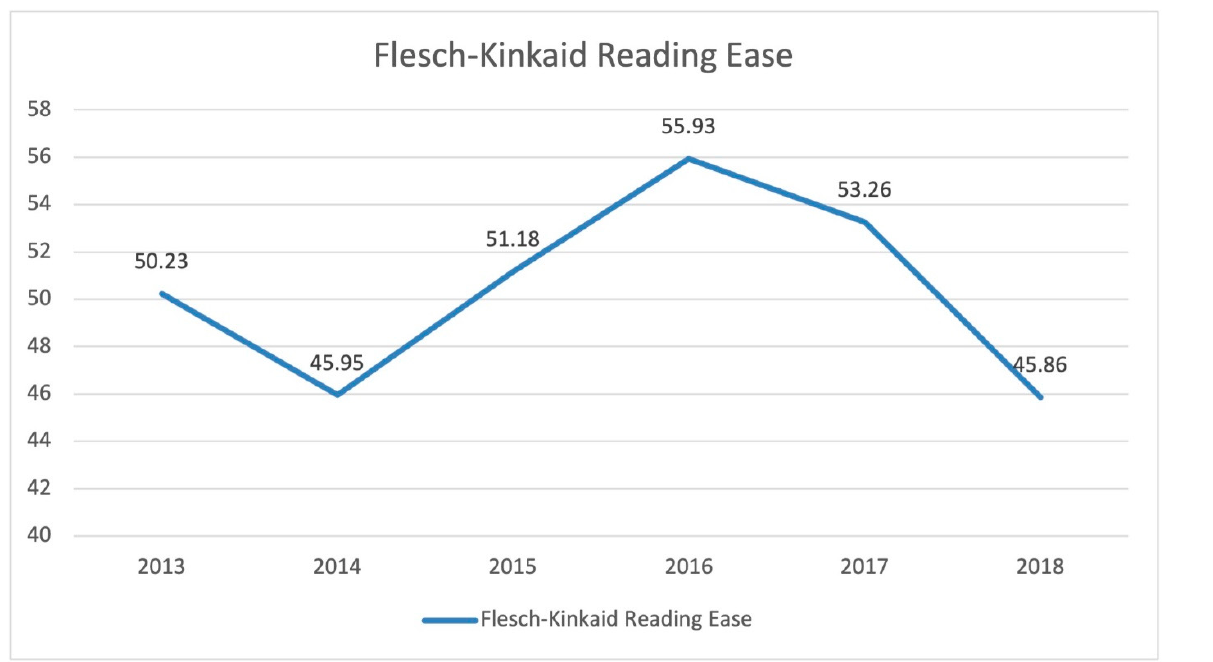
Table 4. Descriptive statistics of the Flesh Kincaid Reading Ease (FKRE) Score.